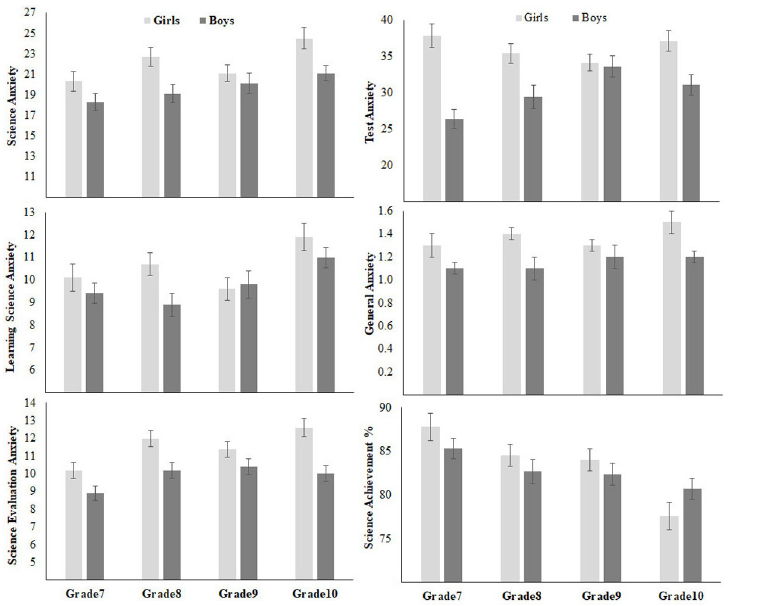
Fig 4. Gender and grade differences in Study